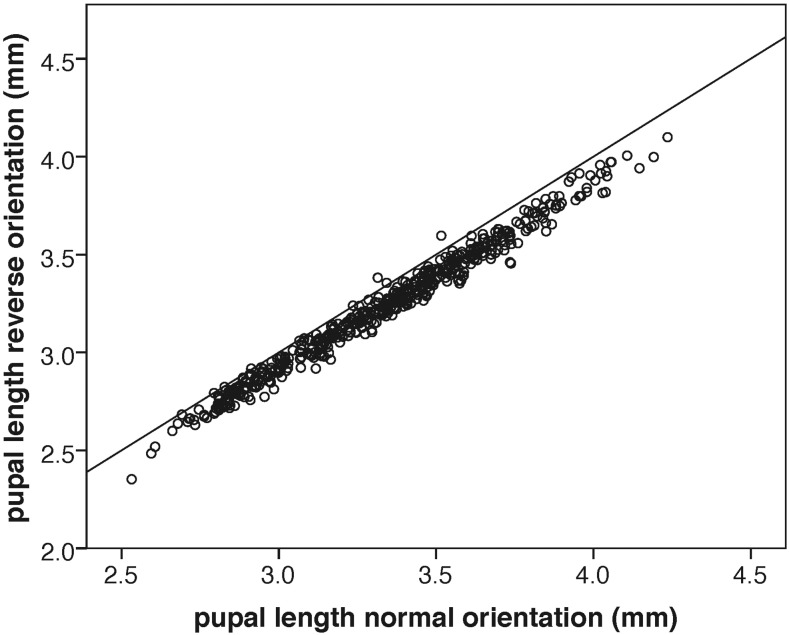
Precision of automated pupal length estimates. Comparison of pupal length measurements of films in the normal orientation compared to where the same film was rotated by 180° All pupae isolated from others by up to 15 pixels in any direction were used (n = 516 pupae, across 10 vials). Slope = 0.94 and R2 = 0.98. An x = y line is shown for reference.